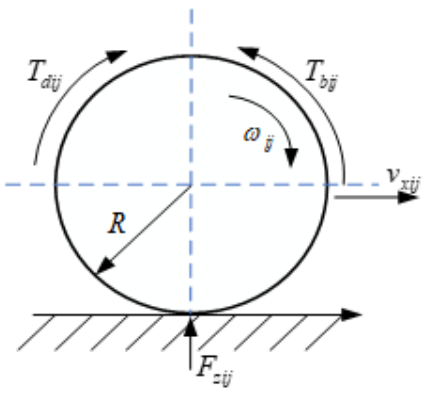
Figure 2. The force state of the